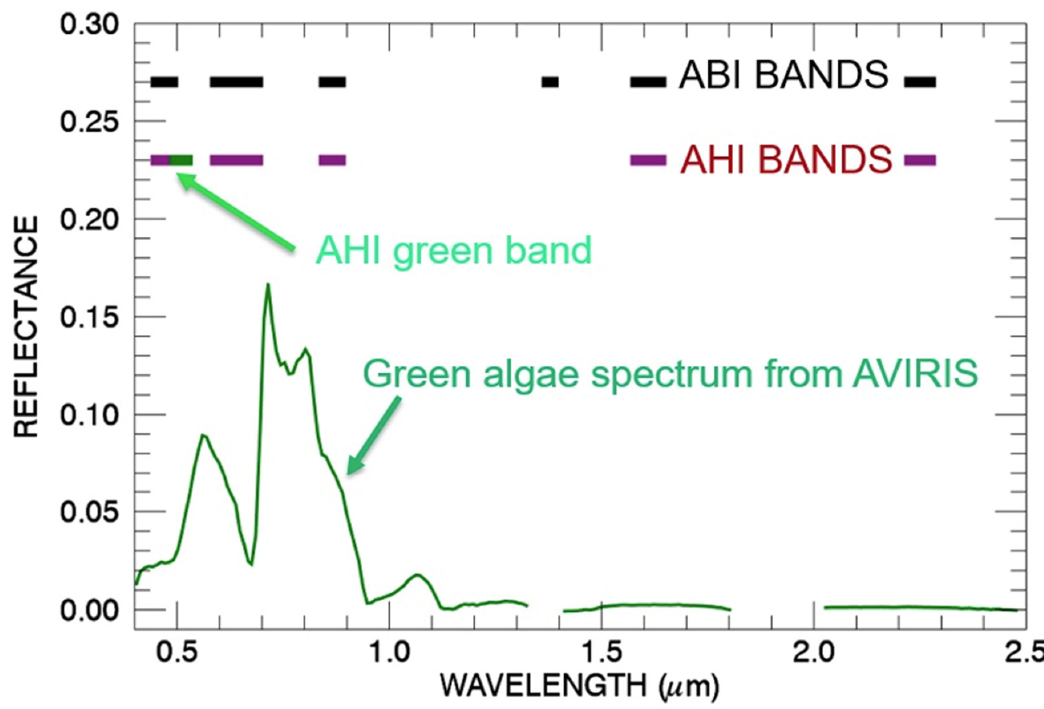
Figure 3. Bandpasses of ABI and AHI instruments. An airborne visible infrared imaging spectrometer (AVIRIS) green algae reflectance spectrum is also shown.